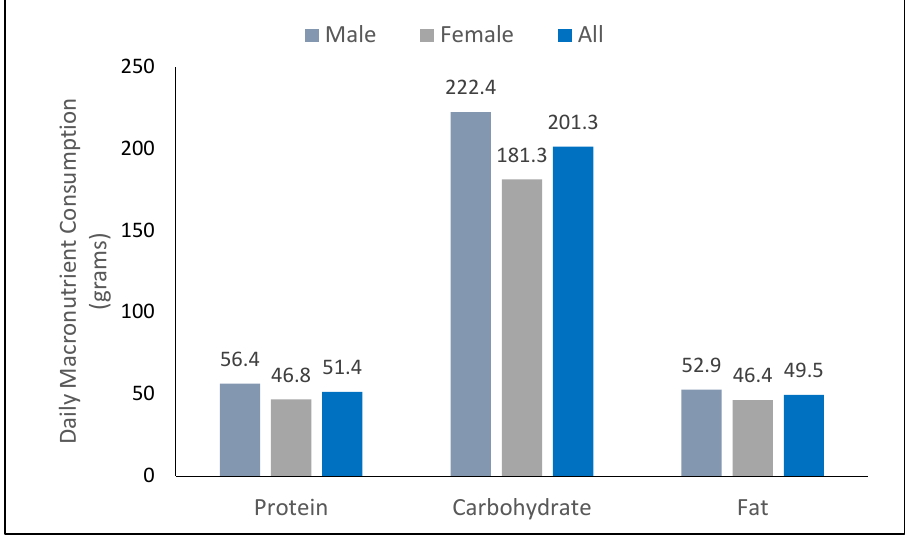
Figure 2. Daily macronutrient consumption. Although the percentages of total kilocalories from protein, carbohydrates, and fats for both males and females fell within acceptable macronutrient distribution ranges for daily consumption by adults in the US as recommended by the Food and Nutrition Board, Institute of Medicine, National Academies [32], protein as percent of total kilocalories was at the lower recommended ranges for daily consumption. Table 1 provides a comparison of the IOM’s AMDR with participant daily intakes. Participants had lower than recommended daily ranges for total fiber consumption (16.10 g for females and 19.00 g for males, IOM recommendations ranged 21–25% for females and 30–38% for males) and dramatically less than the maximum allowances for sugar (<1% for both males and females; IOM maximum allowance is 25%). No recommendations were given by the IOM for monounsaturated fatty acids and the nutrient data for this study did not break out polyunsaturated fatty acids into n-6 (linoleic acid) and n-3 ( α -linolenic acid), so those comparisons were not possible. Saturated fat and trans fatty acids were consumed in small quantities by participants (<1% and <<1% respectively), and cholesterol was consumed in relatively small quantities as well (5.35% of total kilocalories for females, and 6.63% for males). Looking at these dietary components by diabetes status reveals that there was a significant difference between the proportion of trans fat consumed of total fat across groups. Non-diabetics consumed the largest proportion (1%), pre-diabetics consumed a smaller proportion (0.2%), and diabetics consumed the smallest proportion of all (0.08%), p = 0.036*. There was a difference in the consumption of cholesterol as a proportion of total fat, but it was not significant ( p = 0.2225). Non-diabetics again consumed the largest proportions (2.67) followed by diabetic (1.85), and then pre-diabetic (1.41), p = 0.0636. These differences were not seen when looking at males alone, but were when looking at females alone, albeit not significantly. Non-diabetic females consumed 1% of total fat from trans-fat, whereas pre-diabetic consumed 0.1%, and diabetic consumed 0.03%, p = 0.0522. For proportion of cholesterol, non-diabetic females consumed the most (3.03), followed by pre-diabetic females (1.40), and then diabetic females (0.74), p = 0.0867.